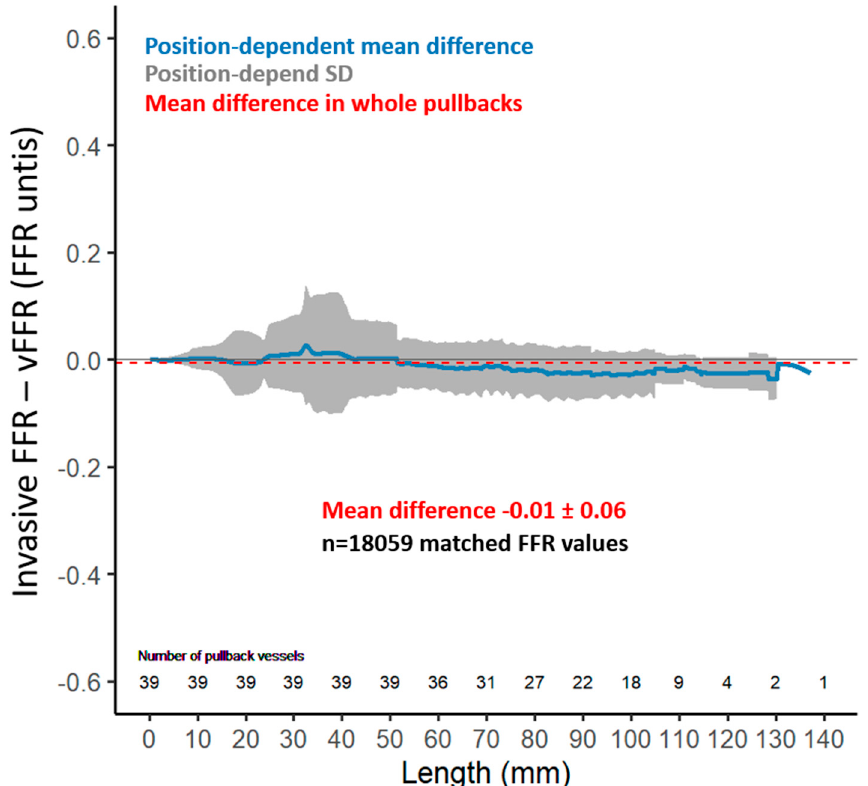
Figure 4. Bland − Altman plot-agreement between invasive FFR and angiography-derived FFR (vFFR) pullbacks. Mean difference − 0.01 FFR units, SD ± 0.06.